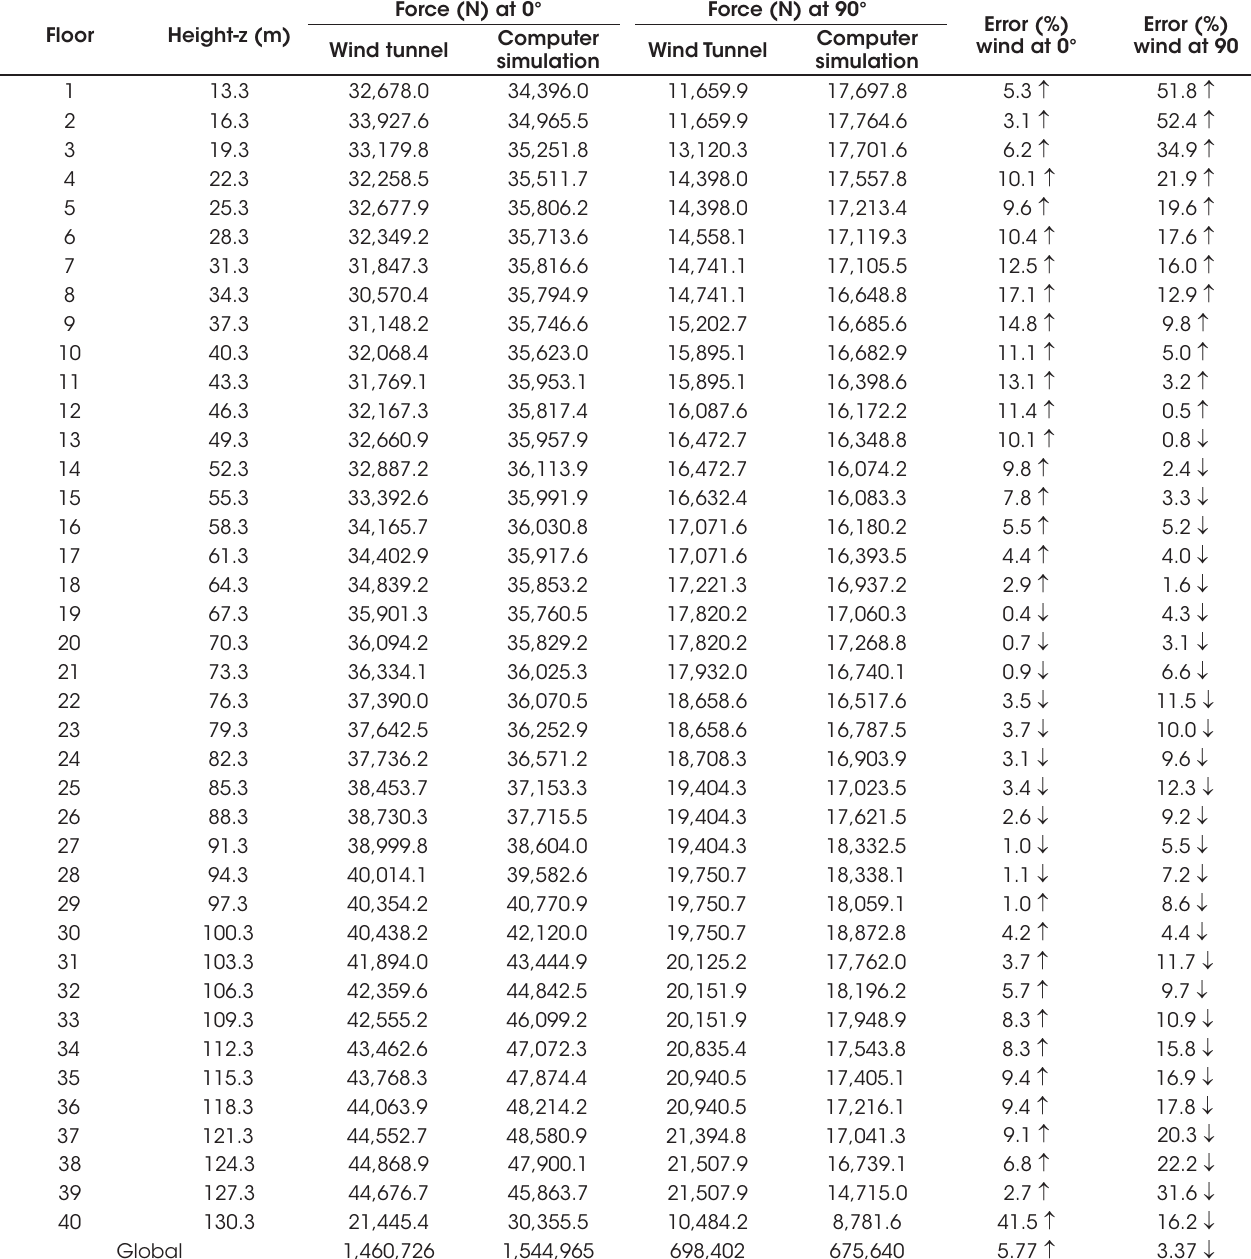
Wind force resultant — incident angles at 0° and